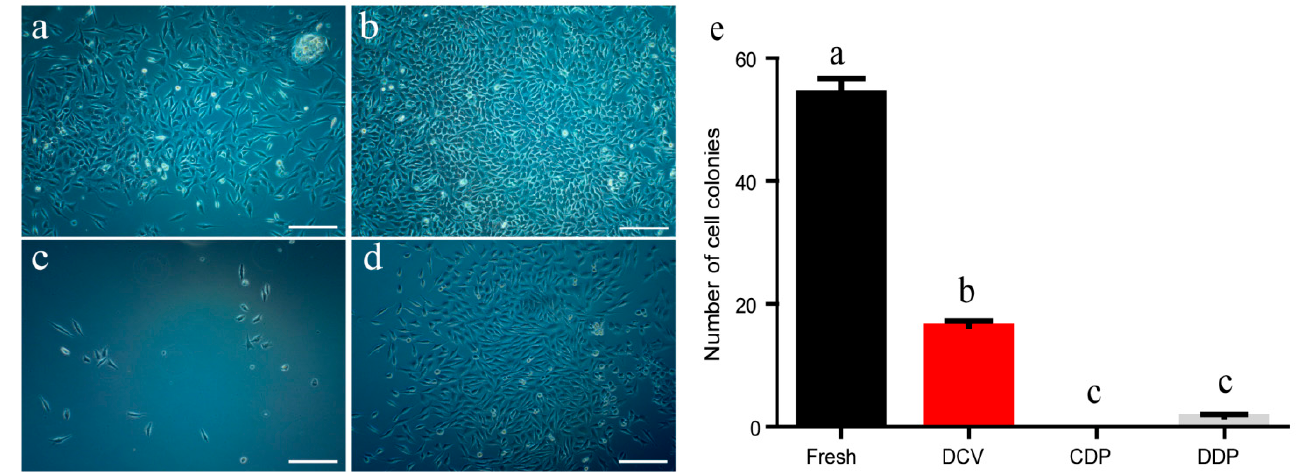
Figure 1. E ff ects of di ff erent vitri fi cation methods on cell viability from thawed ear tissues. ( a ) Cells isolated from fresh tissue; ( b ) Cells isolated from tissues frozen by direct cover vitri fi cation (DCV) method; ( c ) Cells isolated from tissues by cryovials directly plunged into LN2 (CDP) method; ( d ) Cells isolated from tissues by droplet directly plunged into LN2 (DDP) method. ( e ) Number of cell colonies with di ff erent vitri fi cation methods. Error bars represent the SEM. Scale bar = 200 µm.